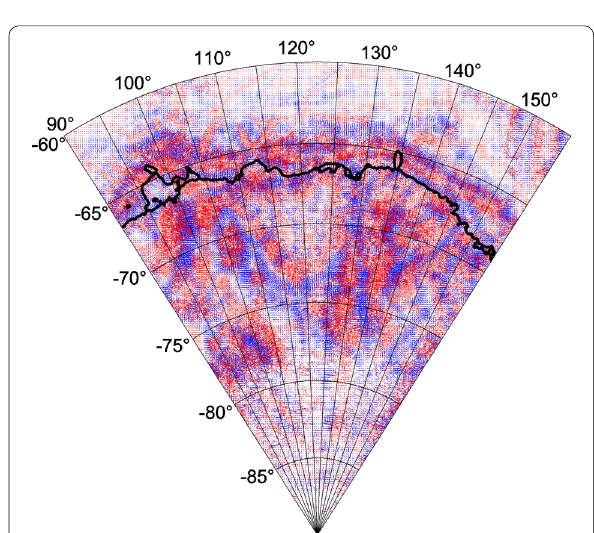
Fig. 10 vd [–] in the Wilkes Land anomaly area, using the RET 14 model (red for dilatation, blue for compression)